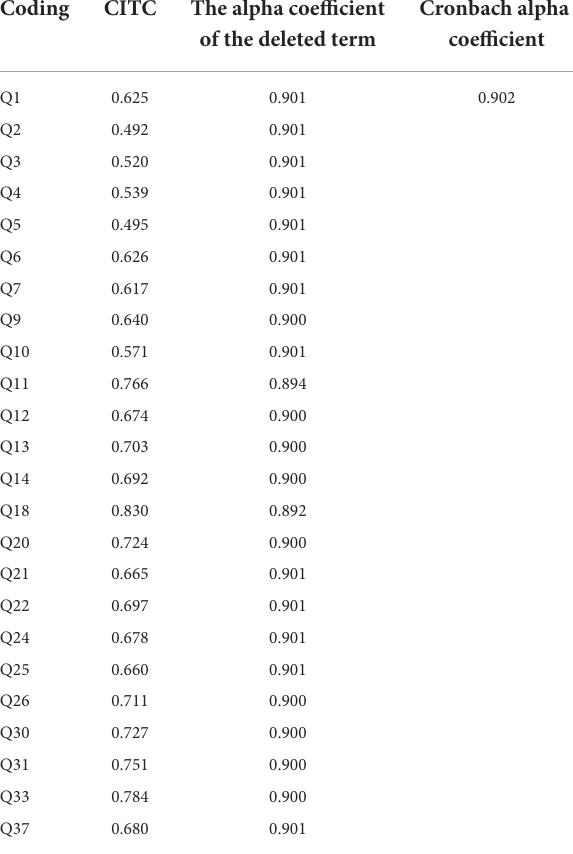
TABLE 8 Results of the reliability analysis of the items. TABLE 9 Results of the discrimination analysis of items.